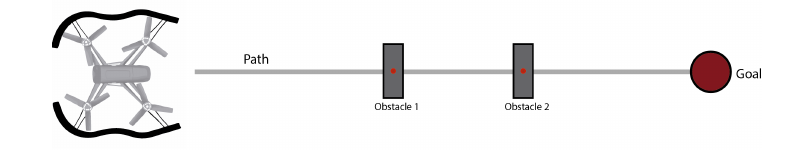
Figure 17. Distribution for two fixed obstacles.